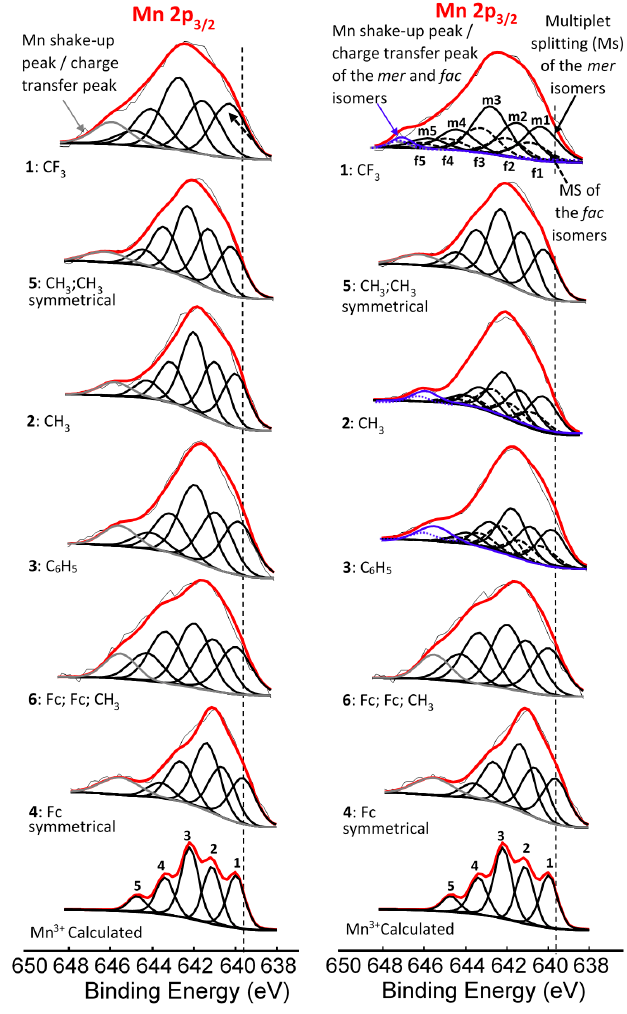
Figure 5. Left : Comparative XPS spectra showing muliplet splitting for the main Mn 2p 3/2 peaks as well as the shake-up peak of the Mn 2p 3/2 of complexes 1 – 6 . Right : Multiplet splitting (Ms) of both the mer (solid line) fac (dashed line) isomers. In both XPS comparisons, simulated spectra of the Gupta and Sen calculated multiplet splitting of Mn 3+ is superimposed onto experimental spectra. The vertical dotted lines give an indication of how binding energy shifts.